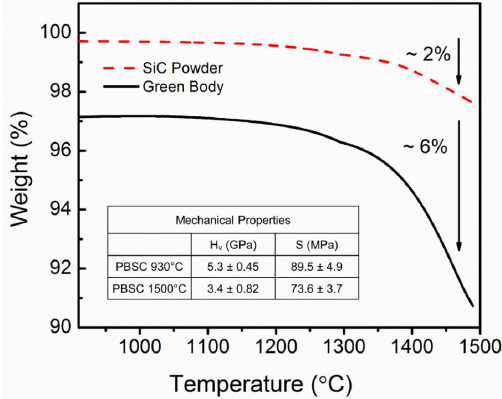
Figure 1. Thermogravimetric analysis of SiC powders and PBSC green bodies showing a mass loss in the 1200 to 1500 °C range and corresponding Vickers hardness and fracture strength of the final pellets from our previous study